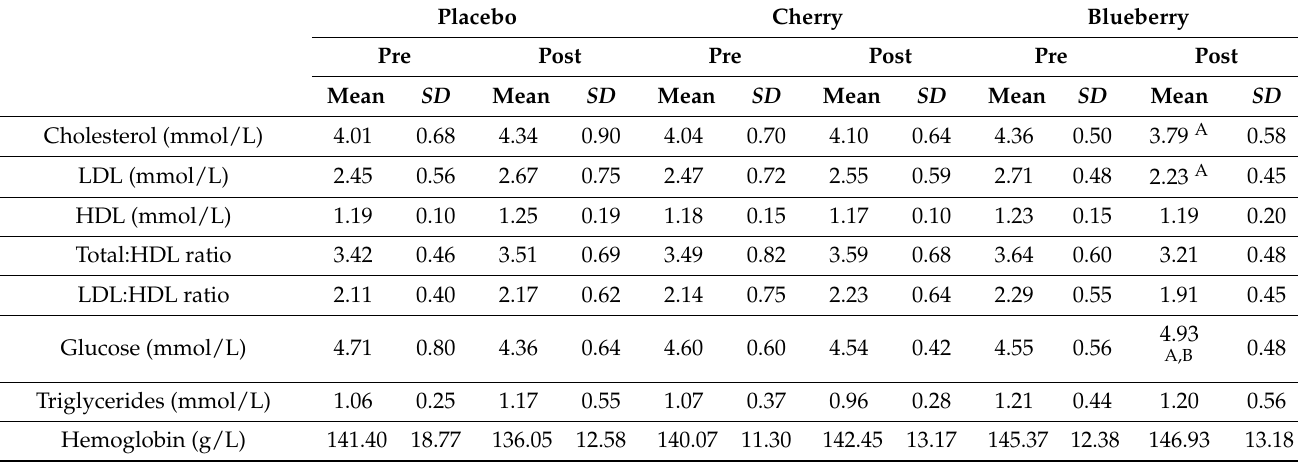
Table 5. Hematological values as a function of each trial